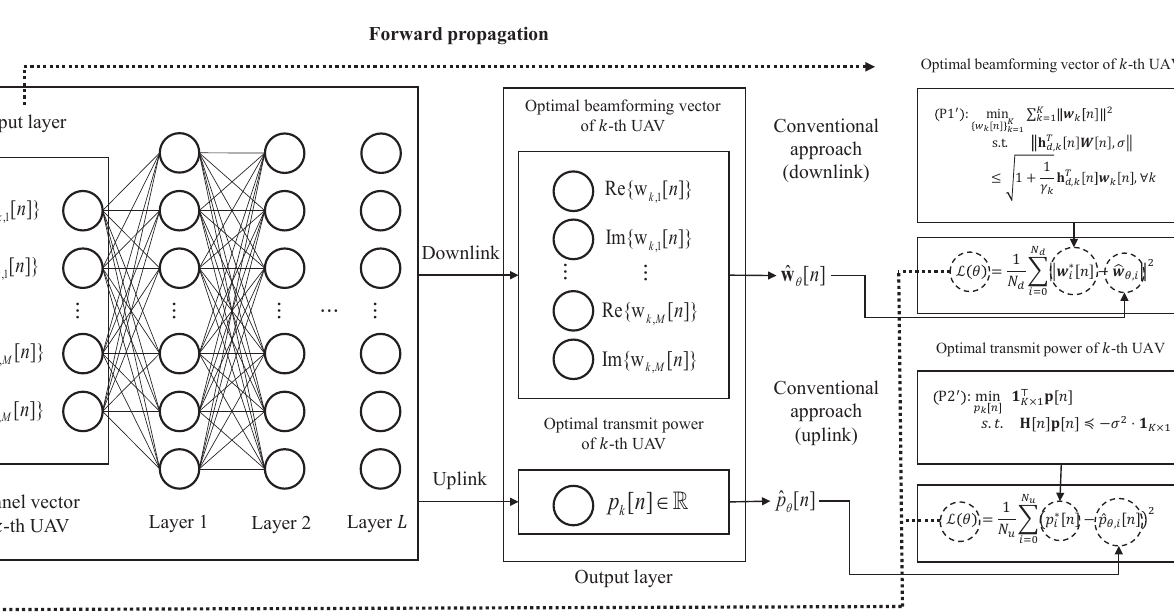
Figure 2. The network structure and loss function of the proposed